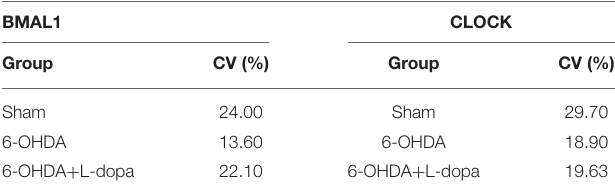
TABLE 4 | The CV of the relative level of BMAL1 and CLOCK during 24h in the sham group, the 6-OHDA-lesioned group, and the 6-OHDA-lesioned + L-dopa group.